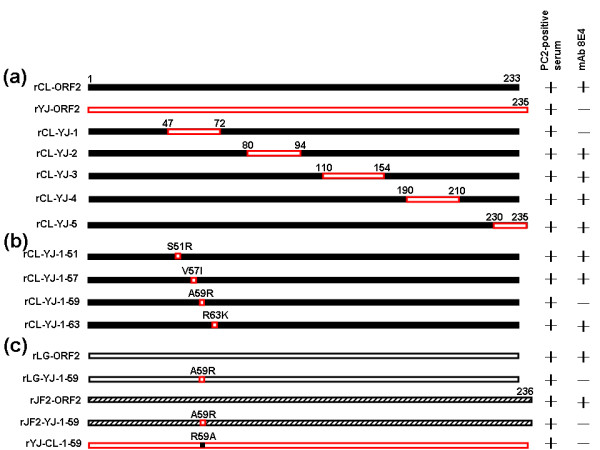
Schematic diagram of PCV2 ORF2 chimeras and mutants and their reactivity with PCV2-positive serum and mAb 8E4. (a) PCV2 clones rCL-ORF2 and rYJ-ORF2 contained the complete 233 aa sequence of PCV2a/CL-ORF2 and the 235 aa sequence of PCV2b/YJ-ORF2, respectively. Five chimeras that consisted of aa 47-72 (rCL-YJ-1), 80-94 (rCL-YJ-2), 110-154 (rCL-YJ-3), 190-210 (rCL-YJ-4) and 230-235 (rCL-YJ-5) of the PCV2a/CL capsid protein were replaced with corresponding regions of the PCV2b/YJ capsid protein. (b) For the second set of constructs, four mutants containing single amino acid mutations of PCV2a/CL-ORF2 at positions 51 (rCL-YJ-1-51), 57 (rCL-YJ-1-57), 59 (rCL-YJ-1-59) and 63 (rCL-YJ-1-63) were substituted for the corresponding amino acids of the PCV2b/YJ capsid protein at the same position. (c) PCV2 clones rLG-ORF2 and rJF2-ORF2 contained the complete 233 aa sequences of PCV2a/LG-ORF2 and the 236 aa sequences of PCV2a/JF2-ORF2, respectively. The PCV2 mutants rLG-YJ-1-59 and rJF2-YJ-1-59 contained a single amino acid mutation from alanine to arginine at position 59 (A59R) in the capsid protein of PCV2a/LG and PCV2a/JF2, respectively. The last mutant rYJ-CL-1-59 contained a single amino acid mutation of arginine for alanine at position 59 (R59A) in the capsid protein of PCV2b/YJ. The IPMA reactivity between each antibody and PK-15 cells transfected with each PCV2 construct is indicated next to each construct. The IPMA reactivity of the constructs in transfected PK-15 cells was demonstrated by PCV2-positive serum and mAb 8E4. +: Positive; -: Negative.